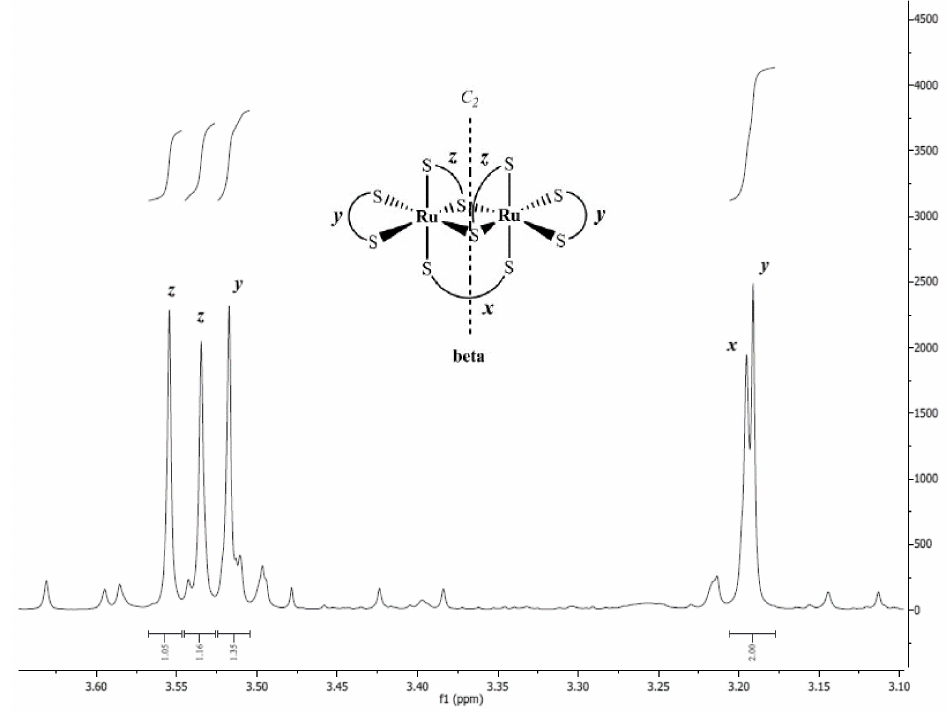
Figure 7. 1 H-NMR spectrum and peaks assignment of β -[Ru 2 (DMDT) 5 ]Br. (CDCl 3 ; 600 MHz). The 1 H-NMR spectra comparison between [Ru 2 (pipeDTC) 5 ]Br, [Ru 2 (DMDT) 5 ]Br and [Ru 2 (pipeDTC) x (DMDT) y ]Br reveals whether each group of signals is relative to the co- ordinated pipeDTC or DMDT, respectively. In particular, two singlets in the spectrum of [Ru 2 (DMDT) 5 ]Br at ~3.2 ppm are clearly missing in the spectrum of [Ru 2 (pipeDTC) x (DMDT) y ]Br (Figure 8). For β -[Ru 2 (DMDT) 5 ]BF 4 , Wheeler and co-workers assigned the two singlets near 3.2 ppm, respectively, to a non-bridging chelate DMDT and the single κ 1 - κ 1 bridged ligand, represented, respectively, by green and the black in Figure 9 ( β -configuration) [20]. Assuming, for simplicity, a perfectly octahedral environment for each Ru atom,